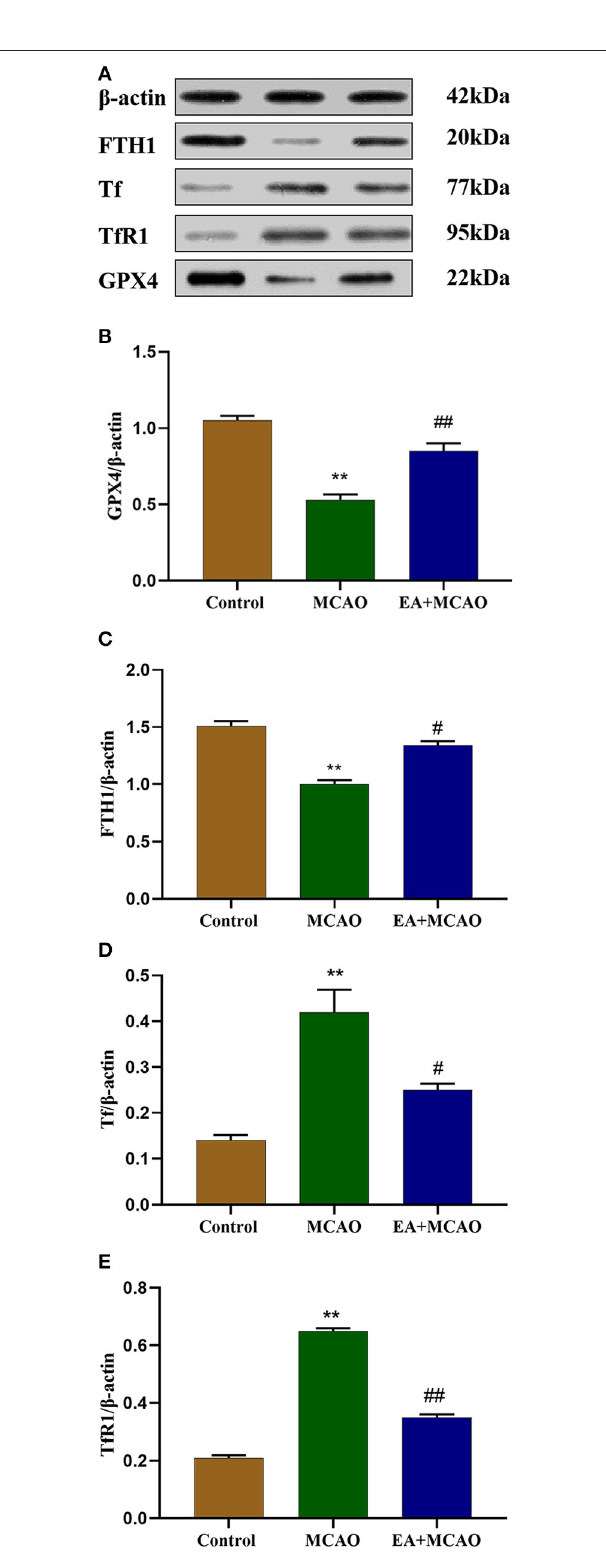
FIGURE 3 | Protein bands (A) and levels of GPX4 (B) , FTH1 (C) , Tf (D) , and TfR1 (E) in each group. Results are expressed as means ± SEM ( n = 6). ** P < 0.01, compared with the Control group; # P < 0.05 and ## P < 0.01, compared with the MCAO group.